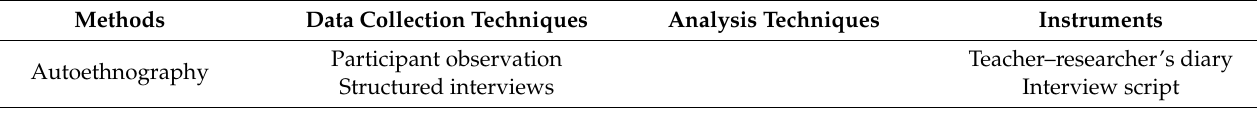
Table 2. Relationship between the methods, techniques, and instruments used in the